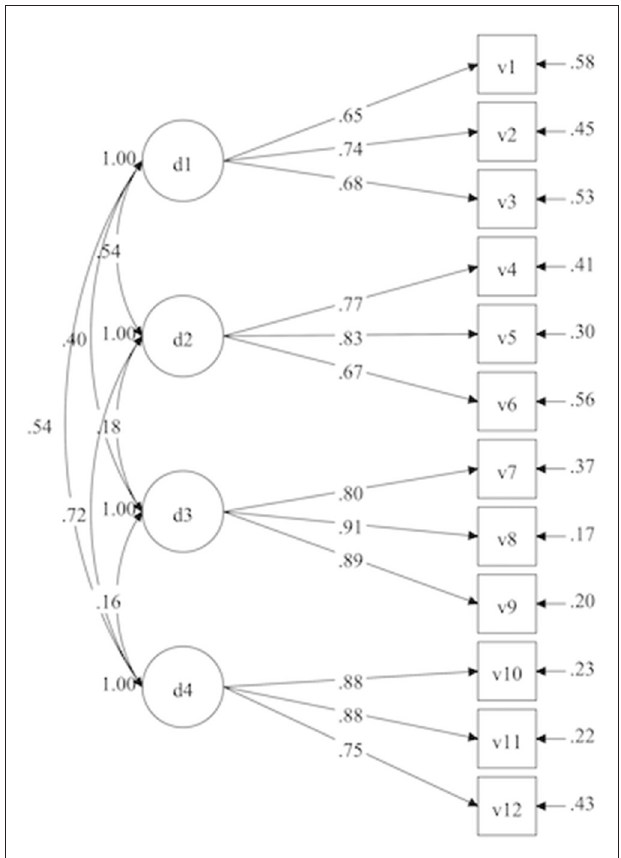
FIGURE 1 | Measurement model.